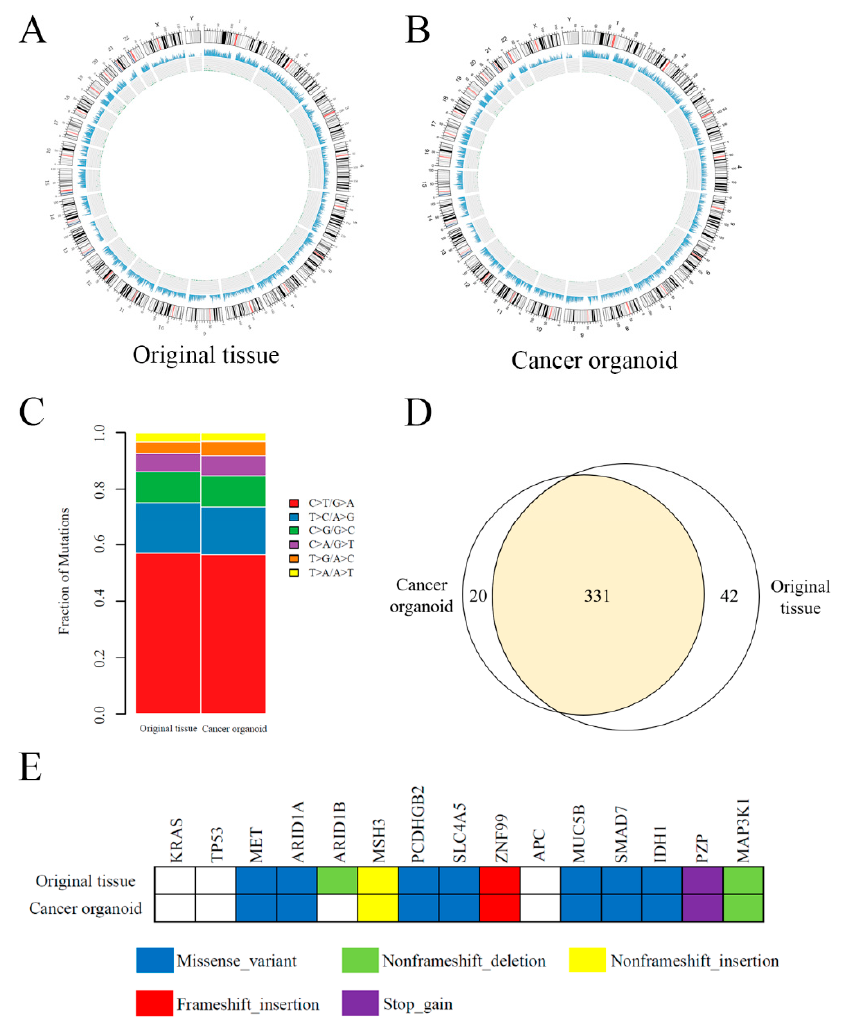
Figure 5. Whole exome sequencing of original tissue and the cancer organoid. ( A , B ) Circos plots of the original tissue and cancer organoid. ( C ) The distribution of base substitutions in the organoid and original tissue. ( D ) Venn diagram demonstrating 89% overlap of single nucleotide variants between the original tissue and cancer organoid. ( E ) Representative variants in the original tissue and cancer organoid.